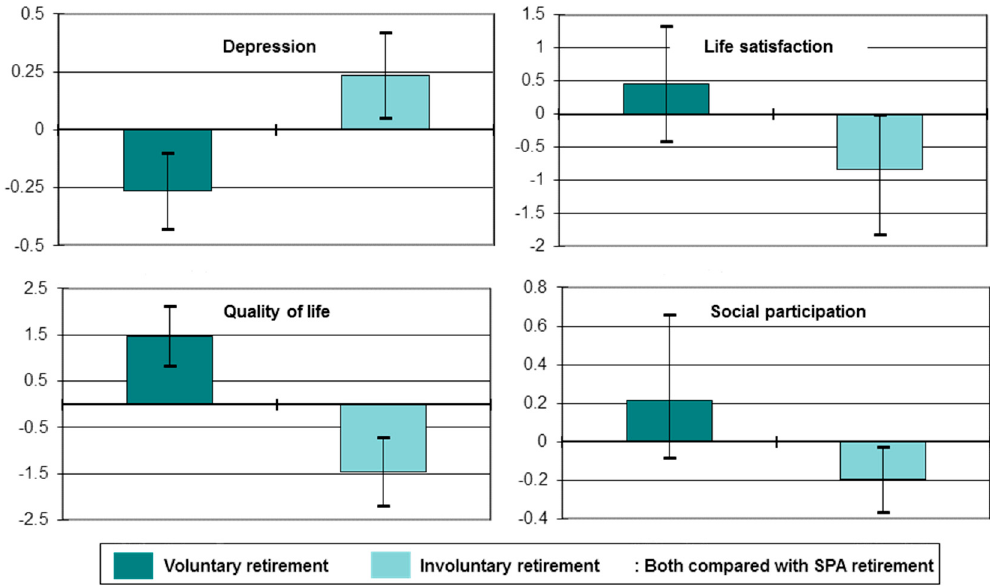
Figure 5. Impact of retirement type on change in health and wellbeing.